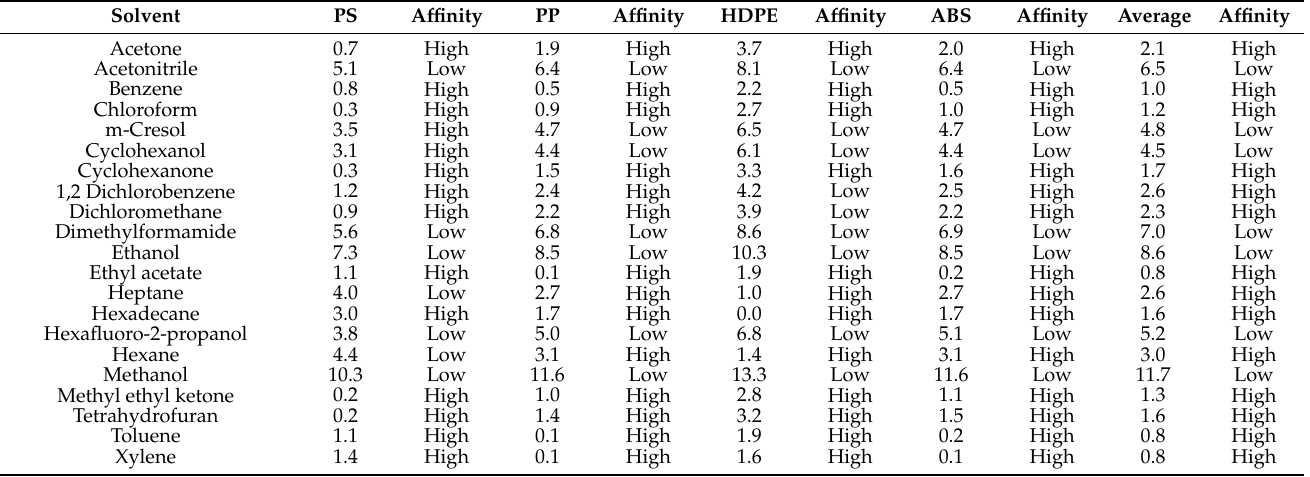
Table 2. Affinity of plastic solubility in various solvents using the Hildebrand solubility